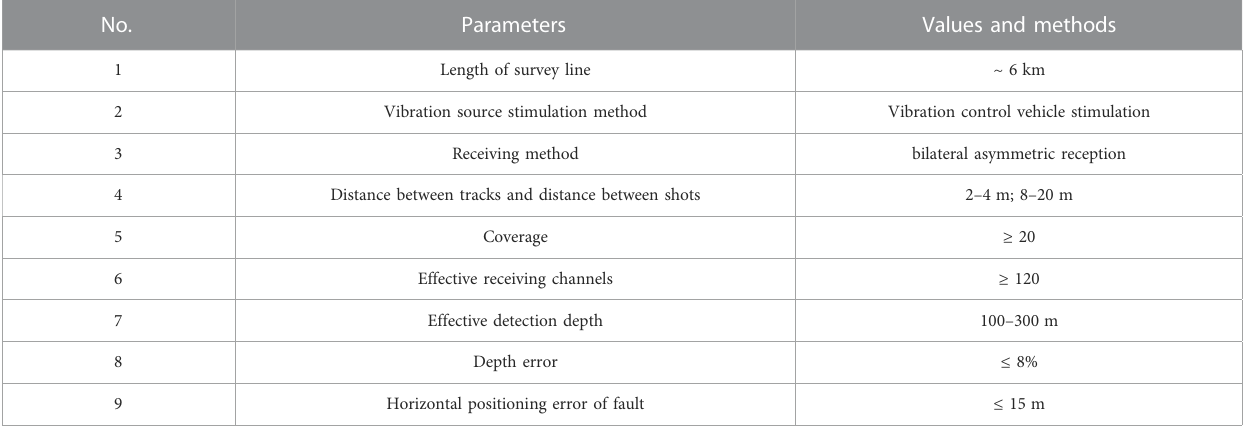
TABLE 1 Parameters and requirements of the shallow seismic survey.